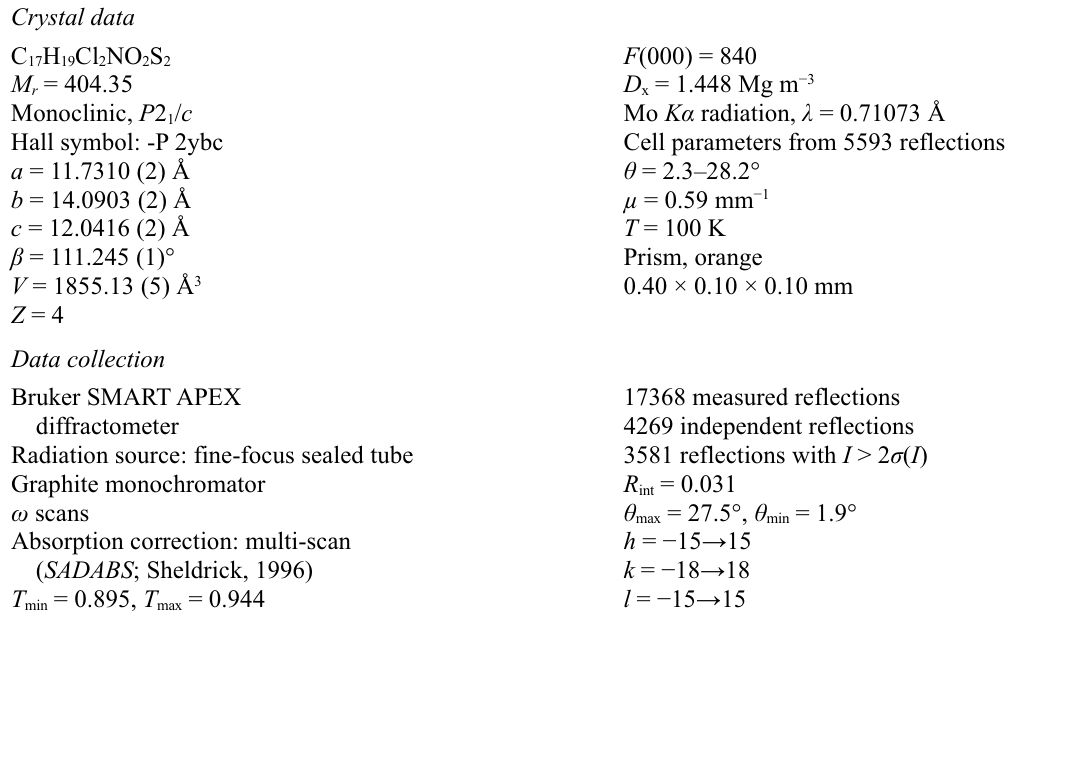
H Cl NO S at the 70% probability level; hydrogen 17 19 2 2 2